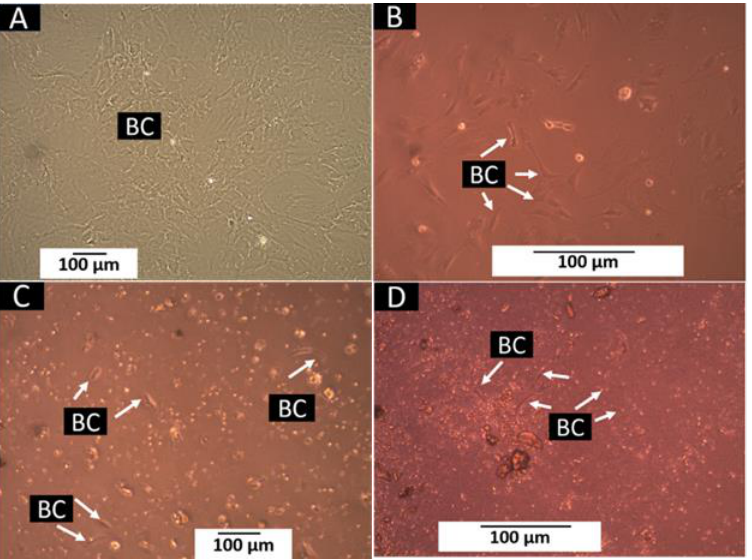
Figure 9. Xenograft samples were cultured with bone cells for six days. ( A ) Growth control well at 10×. ( B ) Growth control well at 20×. ( C ) Well, with F1 at 10×. ( D ) Well, with F2 at 10×. BC: bone cells.